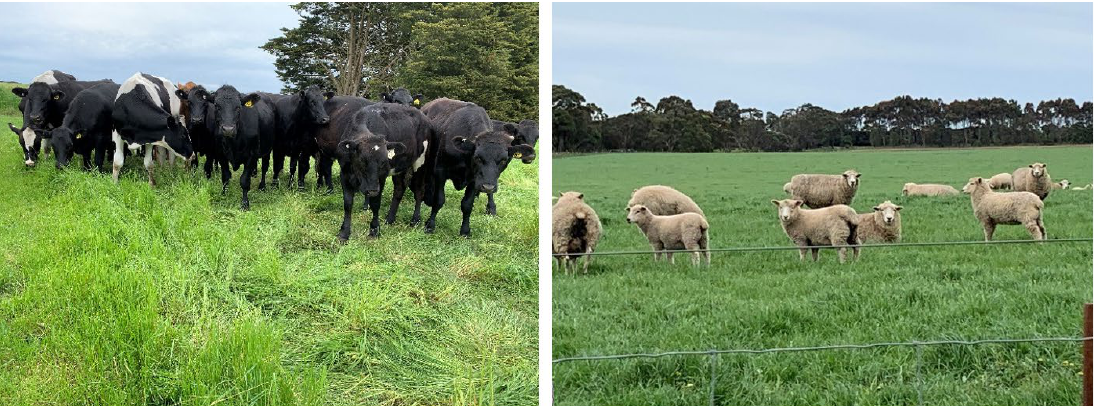
Figure 2. Feeding systems offer high antioxidants such as vitamins, minerals, and bioactives for daily maintenance and performance of farm animals, leading to better animal health, productivity, and milk and meat quality in cattle and sheep. Cattle and sheep (ewes and lambs) grazing solely on tall fescue (left) and perennial ryegrass (right) during spring in regional Victoria, Australia.